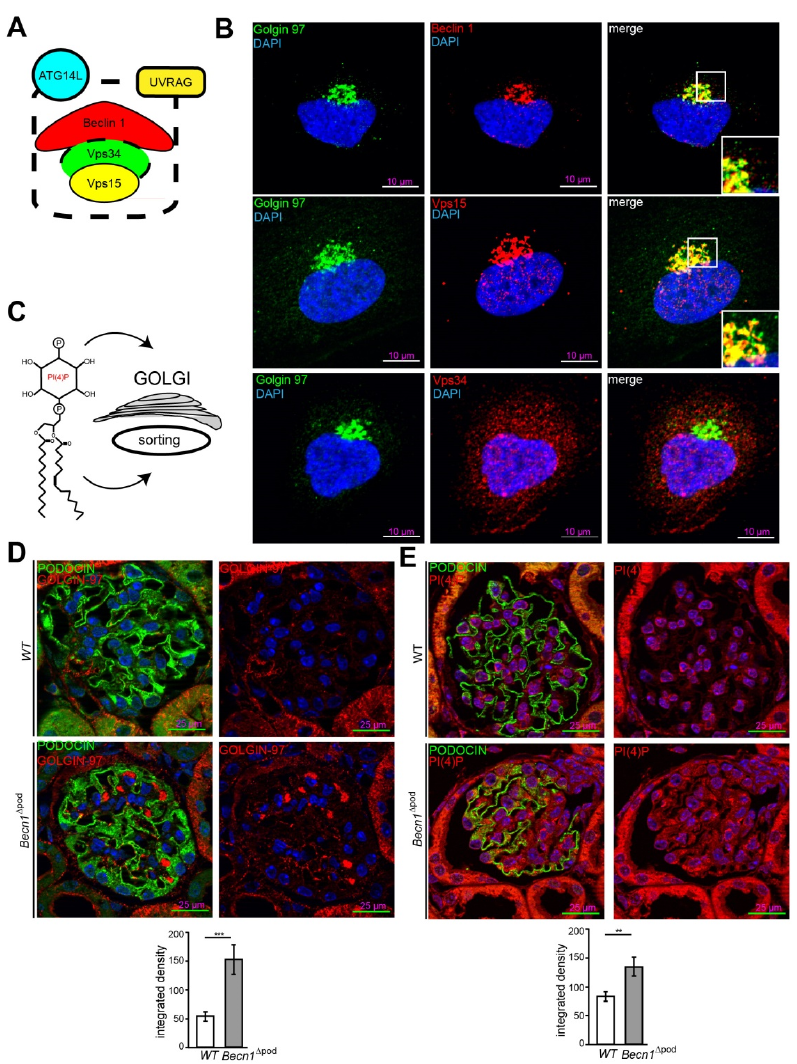
Figure 5. Beclin 1 localizes to the Golgi compartment and regulates Golgi size. ( A ) Schematic showing key interaction partners of the BECLIN1-core complex; ( B ) Immunofluorescence staining for GOLGIN 97 (green), BECLIN1, VPS15 and VPS34 (red) in human podocytes; ( C ) Schematic showing PI(4)P as the key upstream regulator of Golgi size and activity; ( D ) Representative image showing immunofluorescence staining for PODOCIN (green) and PI(4)P (red) in kidney sections obtained from 4-week-old WT and Becn1 ∆ pod mice with the integrated density of the GOLGIN 97 signal quantified (n = 8, *** ≤ 0.001); ( E ) Representative image showing immunofluorescence staining for PODOCIN (green) and PI(4)P (red) in kidney sections obtained from 4-week-old WT and Becn1 ∆ pod mice the integrated density of the GOLGIN 97 signal quantified (n = 8, ** ≤ 0.001).